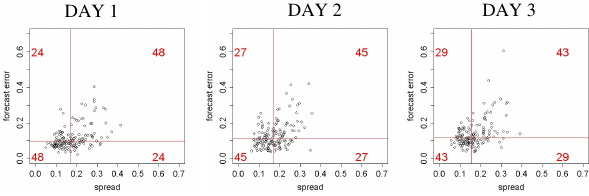
Figure 2. ECMWF deterministic power forecast error (RMSE / NP) vs ensemble power spread computed as a daily average for three lead times. The lines are plotted on the median. The red numbers indicate the points inside each square.